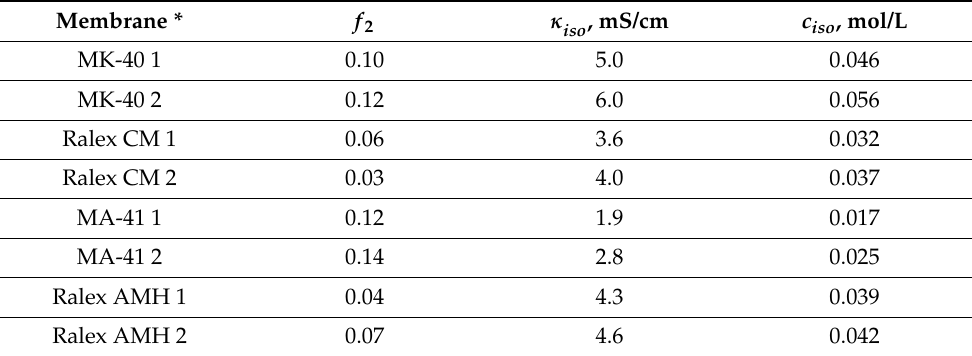
, mS/cm c iso , mol/L iso